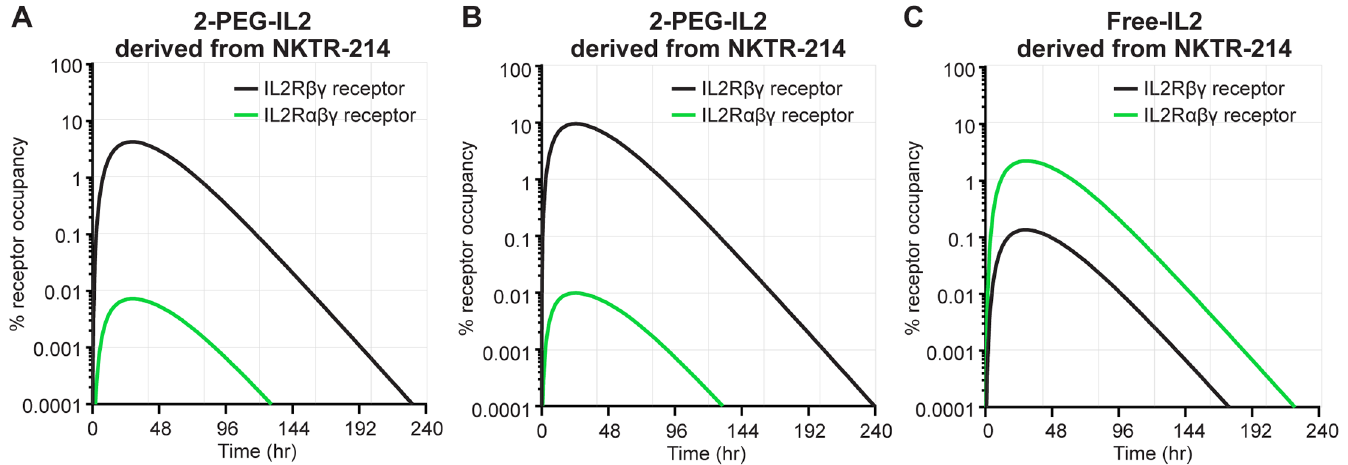
Fig 9. Conjugated-IL2 species derived from NKTR-214preferentially occupy IL2R βγ over IL2R αβγ . Percent receptoroccupancycalculatedby the model from A. 2-PEG-IL2, B. 1-PEG-IL2, and C. free-IL2 derivedfrom NKTR-214, at IL2R βγ (gray lines) and IL2R αβγ (green lines) receptorcomplexes.